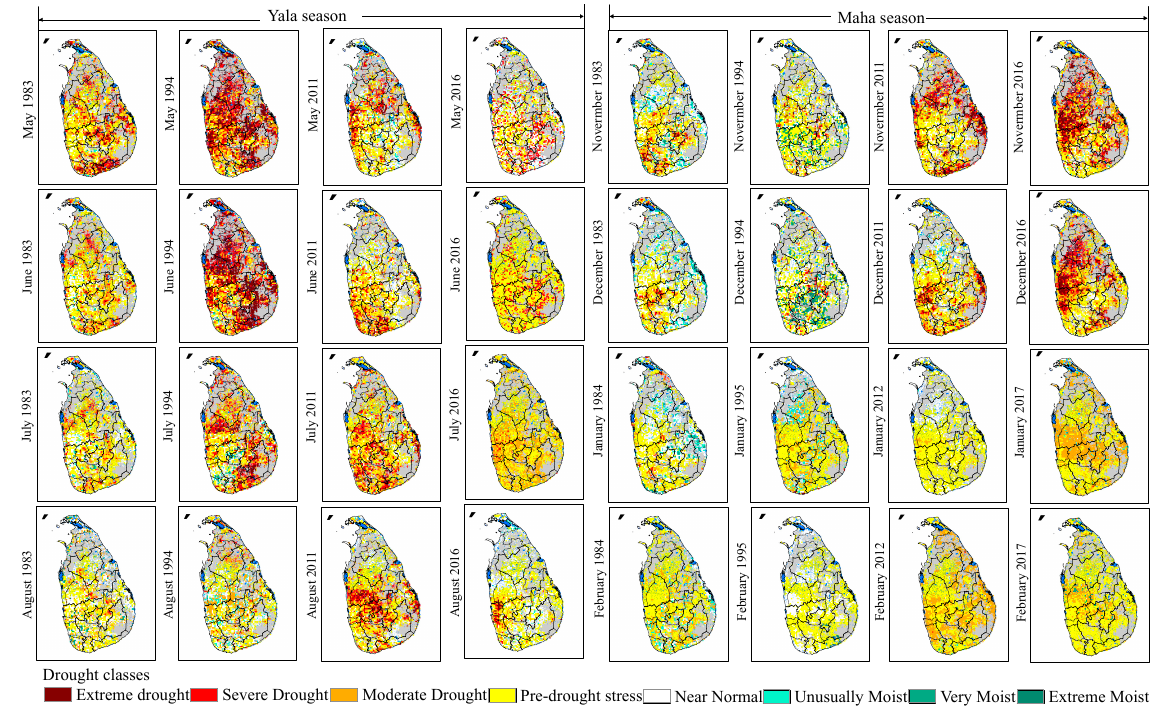
Figure 9. Spatial patterns and severity of selected historic drought years (i.e., 1983, 1994, 2011, and 2016) in Yala and Maha seasons.